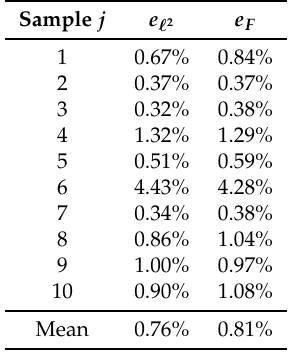
Table 3. Percentage error of the local stiffness matrix A K 0 c in experiment